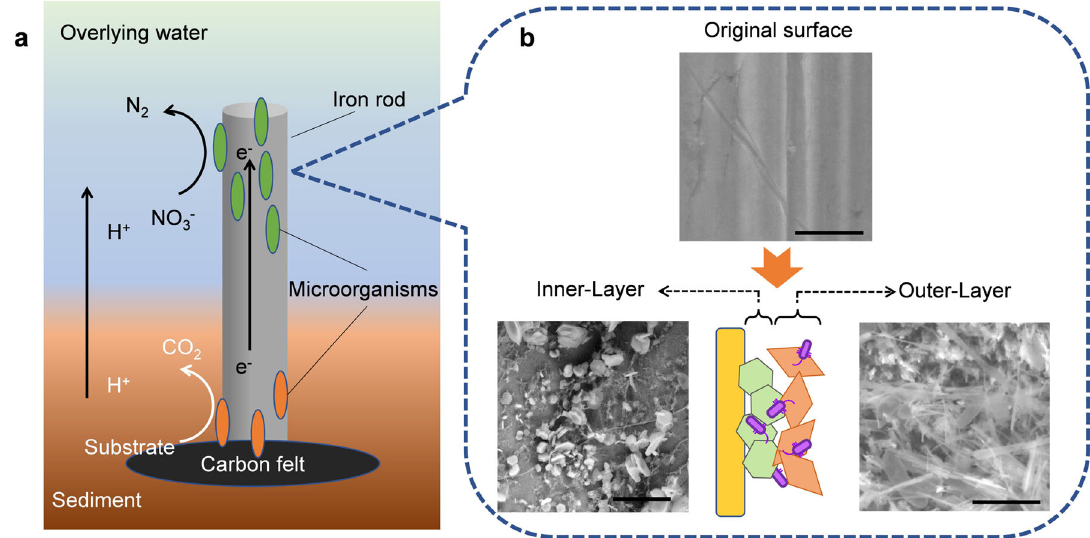
Fig. 1 Nitrate reduction process of Fe-sediment system and changes of iron rod surface. a Nitrate reduction process induced by iron rod. Electrons in sediment are conducted by an iron rod and transferred to nitrate in the overlying water. b SEM images of iron rod surface changes. The surface of the iron rod changed from the initial smooth state to a double-layer structure. The outer-layer crystals were needle- shaped, while the inner-layer crystals were mainly regular hexagons. Scale bars, 2